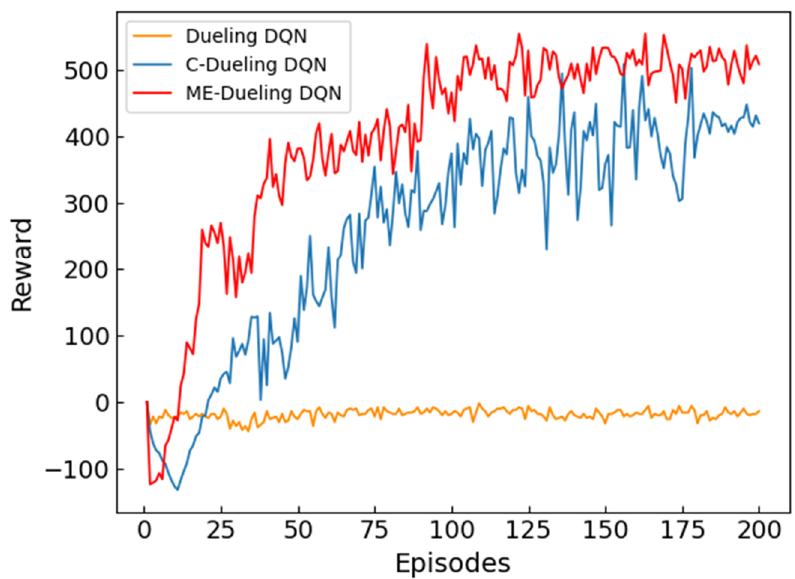
Figure 5. The convergence analysis of each algorithm.